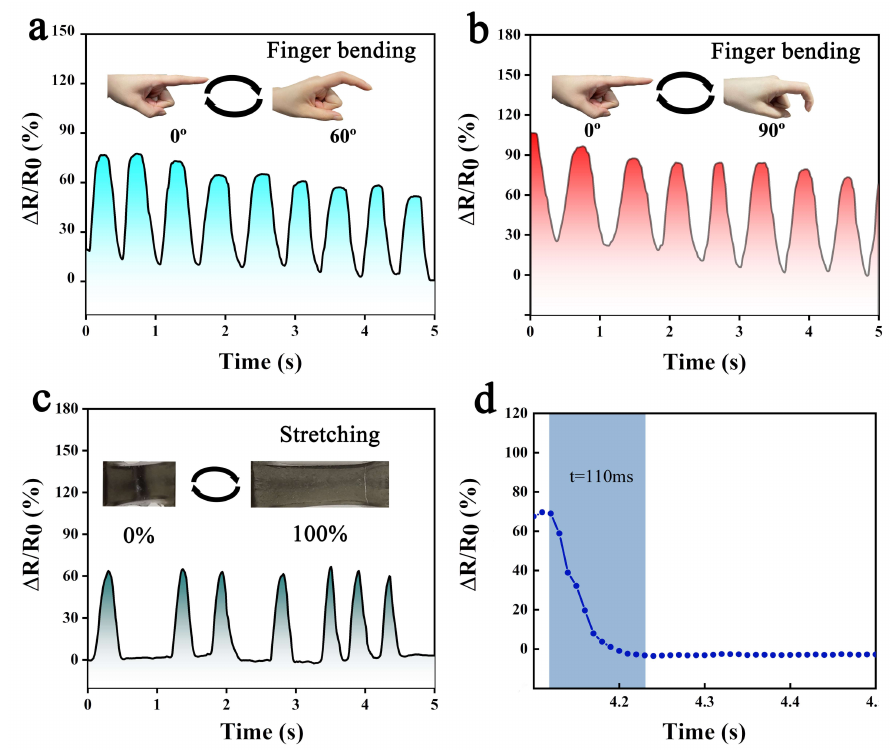
Figure 8. ( a ) Sensing performance at 60 ◦ finger flexion; ( b ) Sensing performance at 90 ◦ finger flexion; ( c ) Sensing performance of PAEM stretched to 100%; ( d ) Response time of PAEM